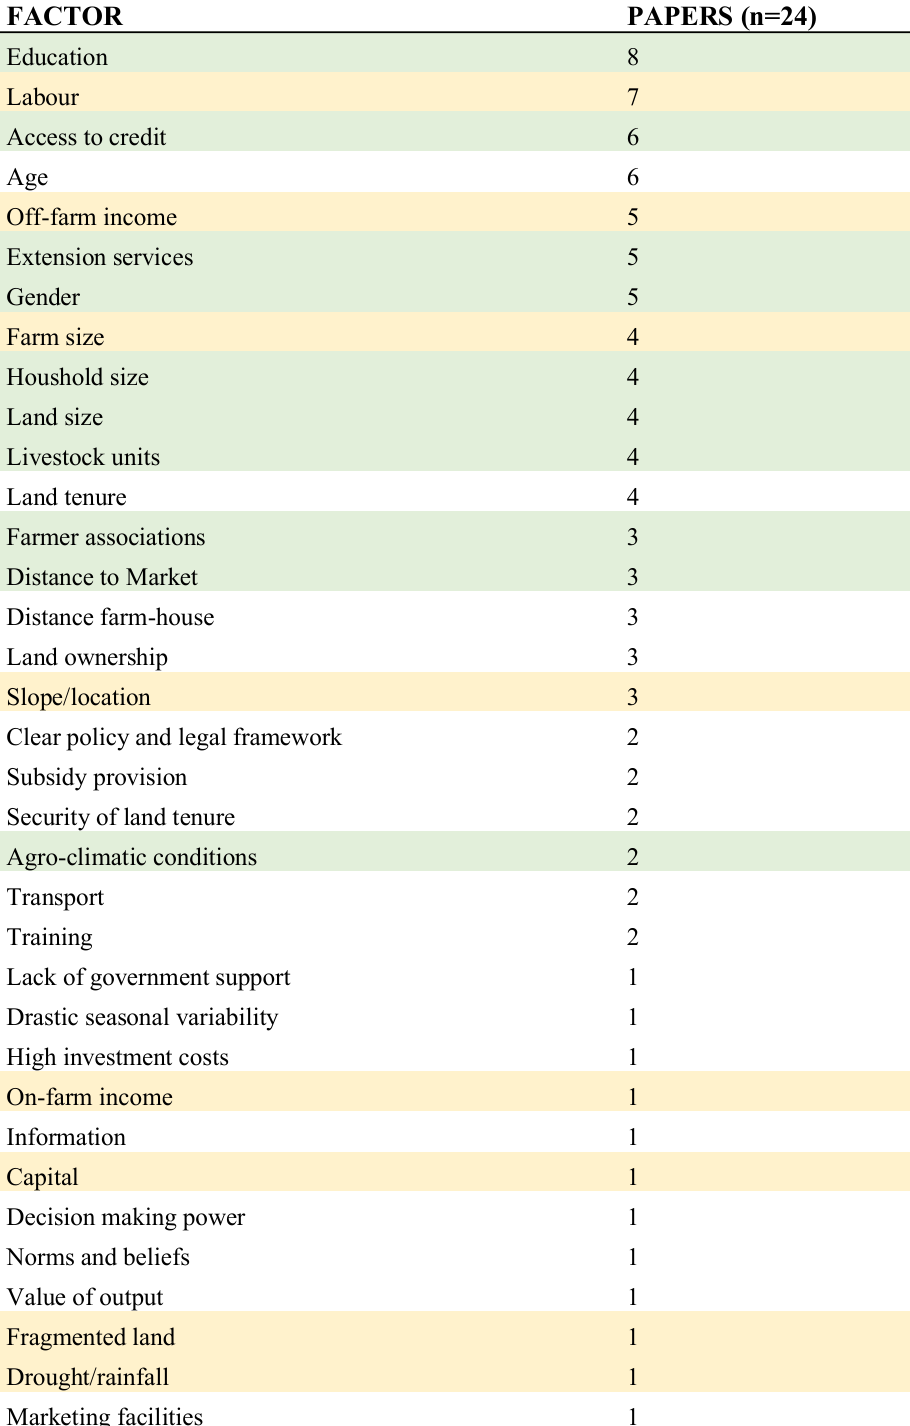
Table A1.1 . List of factors associated to adoption of agricultural innovations in Uganda from meta- analysis. In green are the factors selected as attributes for the analysis and in orange the factors that are included as proxies in some of the selected attributes (e.g. the factor “land size” was selected as spatial attribute, but it also represents a proxy of farm size (Prestele Reinhard et al.,